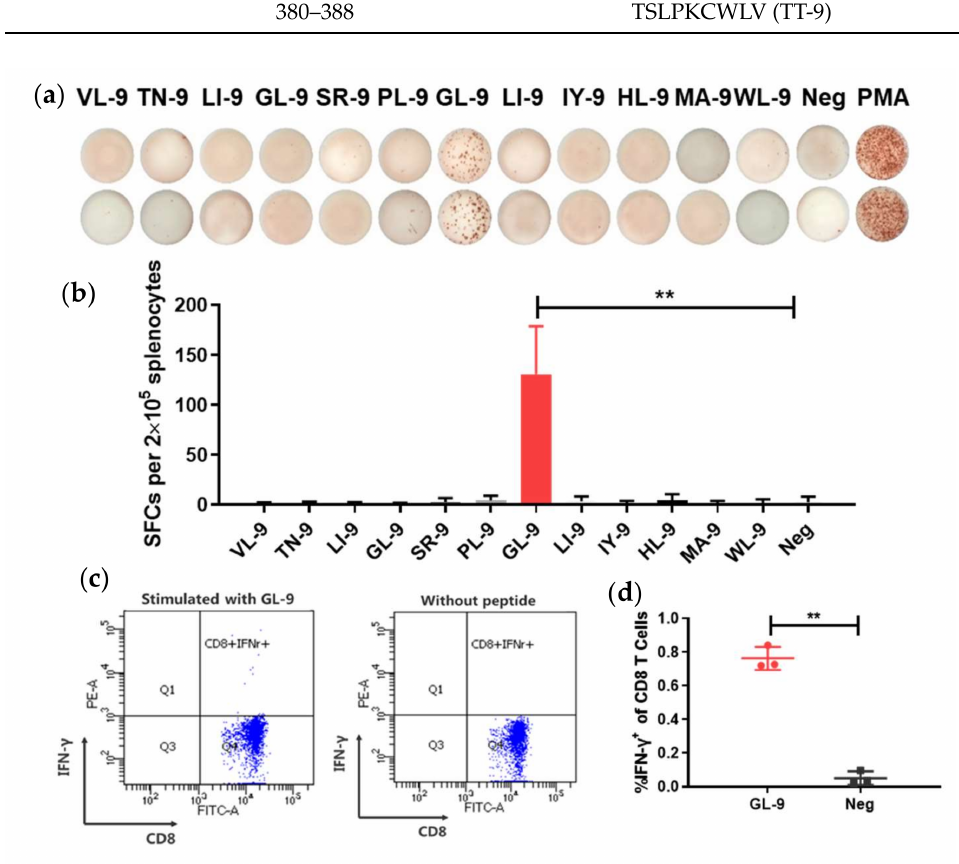
Figure 4. Evaluation of H-2 d -restricted epitopes in LASV GPC. ( a , b ) BALB/c mice were immunized with Ad5-GPC LASV at day 0. Splenocytes were extracted at 14 days post immunization and stimulated with the different peptides from LASV GPC for interferon (IFN)- γ enzyme-linked immunospot (ELISPOT) assays. ( c , d ) To further verify the identified peptide, splenocytes were stimulated with GL-9, and CD8 + T cells were assayed by intracellular IFN- γ staining. Abbreviations: IFN- γ , interferon γ ; SFCs, spot forming cells. Data are presented as mean ± SD, and statically significant differences (Student’s t -test) are marked by bars and asterisks (** p <